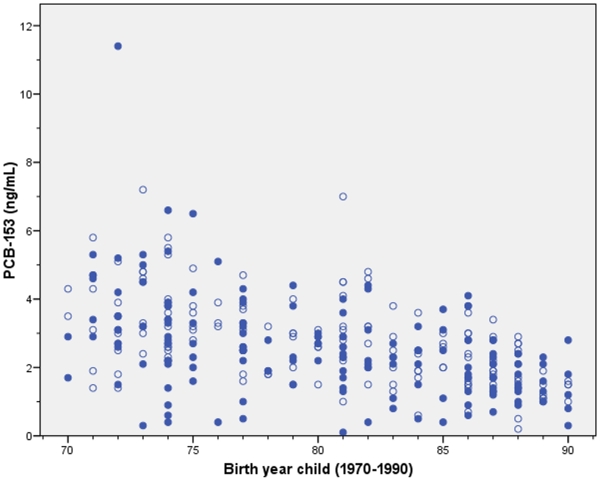
The median maternal serum concentrations of PCB-153 from 1970–1990.